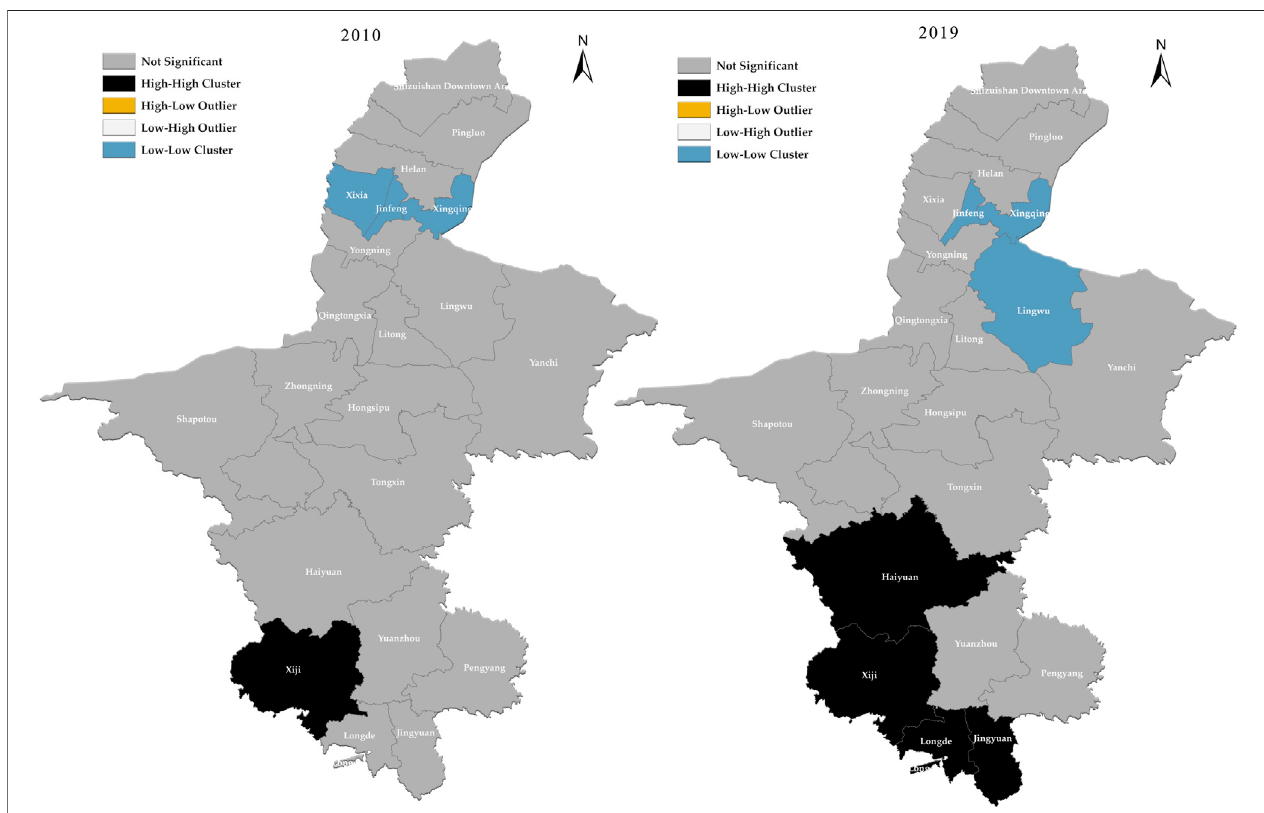
FIGURE 8 | The Local Global Moran ’ s I of Ningxia ’ s inconsistency index in 2010 and 2019.